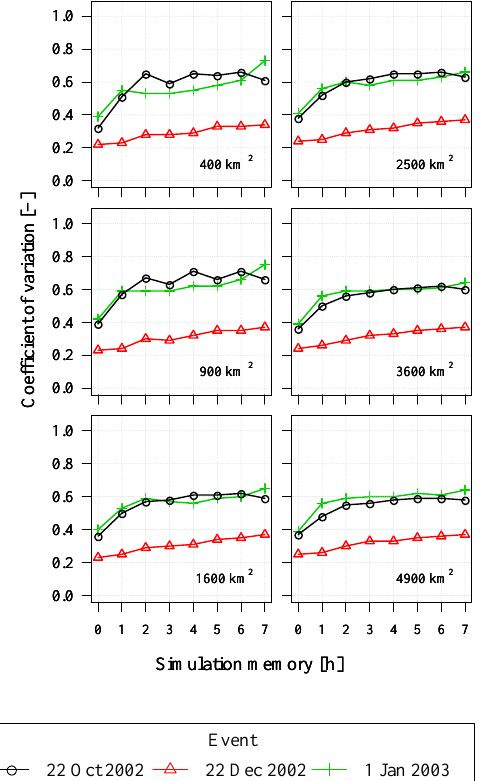
Fig. 14. Real-world experiment. Coefficient of variation (CV J ) for different catchment sizes and three rainfall